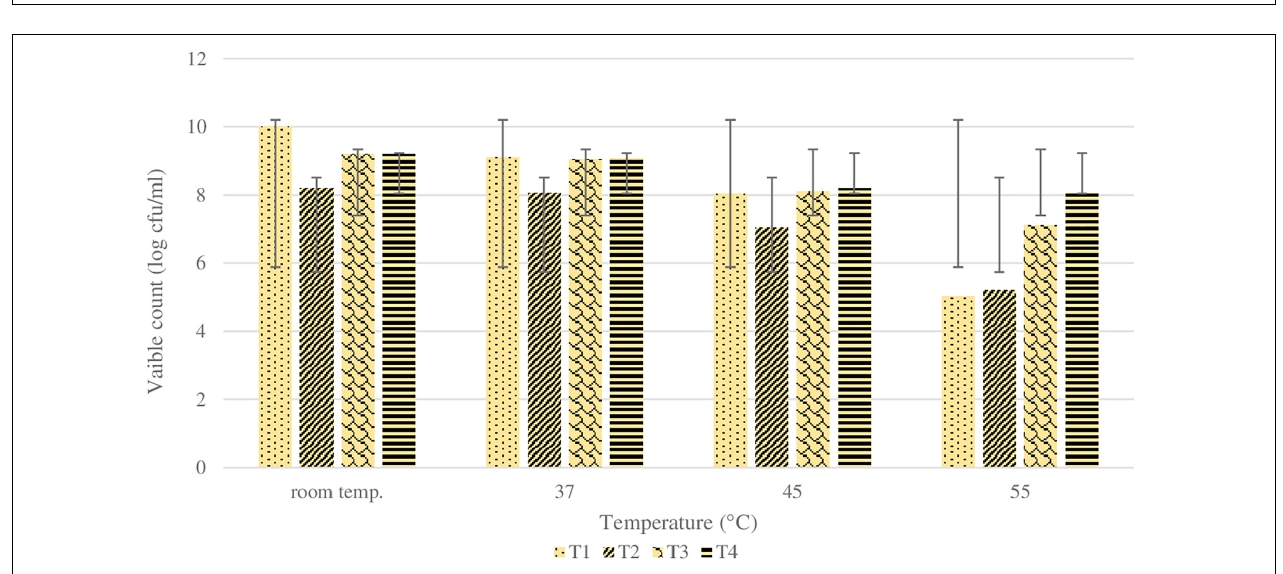
FIGURE 6 | Survival rate of plain and coated L. rhamnosus under simulated intestinal fluids after 30, 60 120 and 180 min. Tl: plain L. rhamnosus, T2:coated cells with BSP/Glucomannan, T3: coated cells with ESP/alginate and T4: coated cells with BSP/inulin.